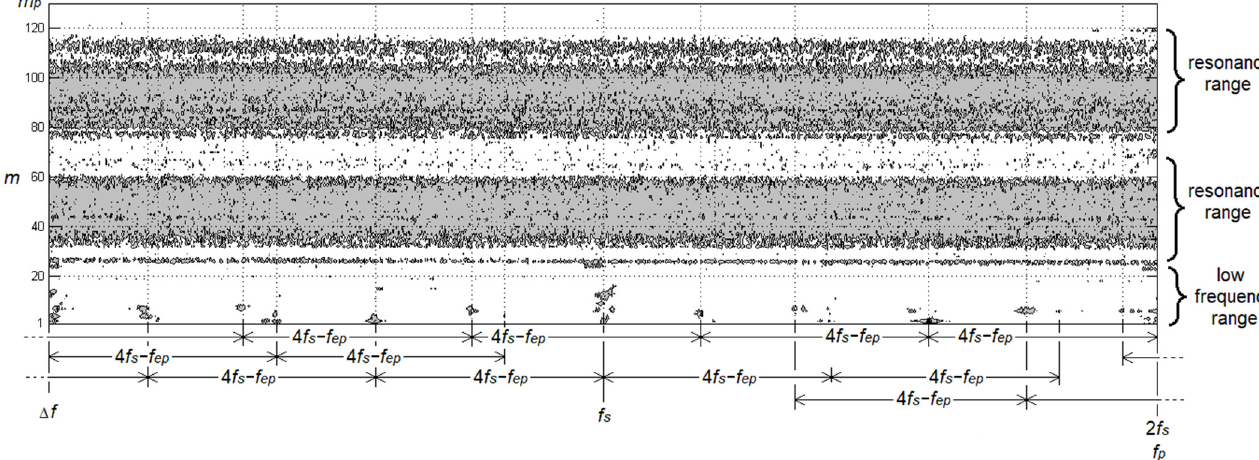
Figure 12. F-F image of the frequency spectrum of the vibration acceleration of the motor’s outer casing with the bearing slackness ( f P = 2 f s ).